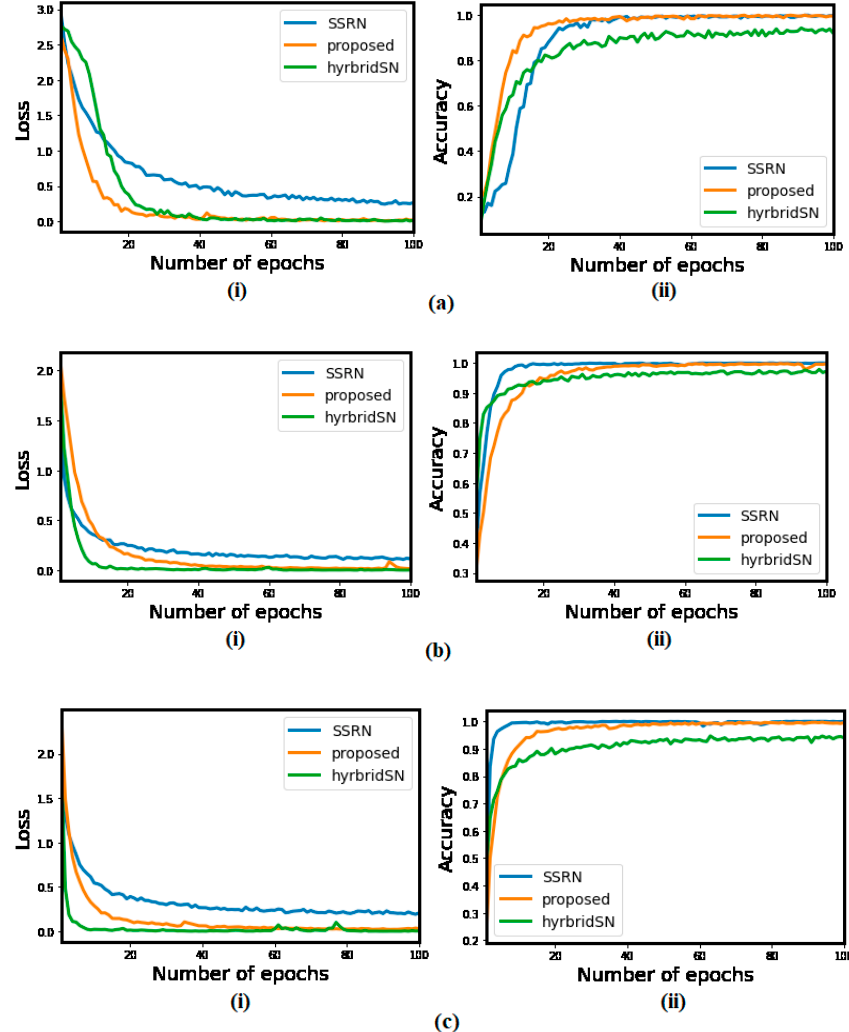
Figure 8. The loss and accuracy convergence graphs of the SSRN, Hybrid, and GGBN for each epoch over the ( a ) IP, ( b ) UP, and ( c ) SA datasets.